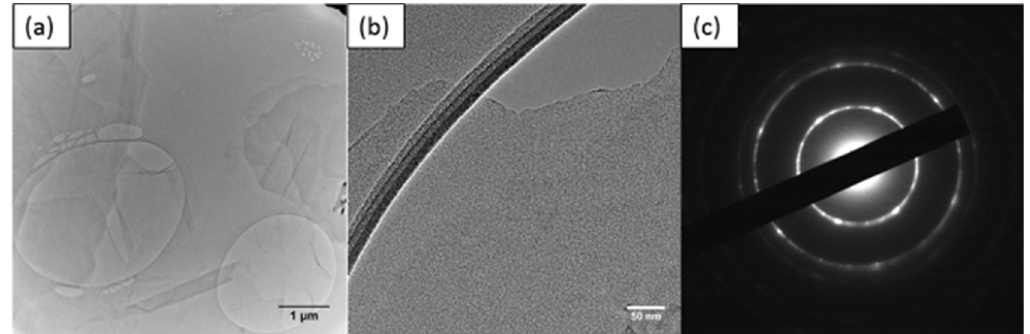
Figure A8. SEM images of ( a – e ) GO sponge at different magnifications, ( f ) GO sheet surface, ( g ) GO single sheet edge, ( h ) GO sponge photo.